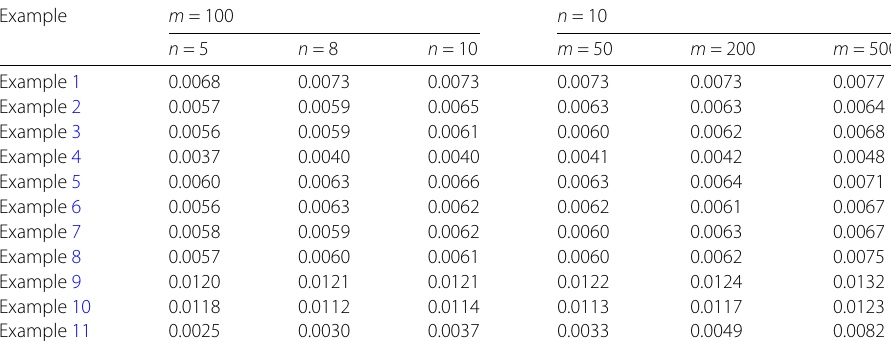
Table 2 Execution time of test examples with different parameters